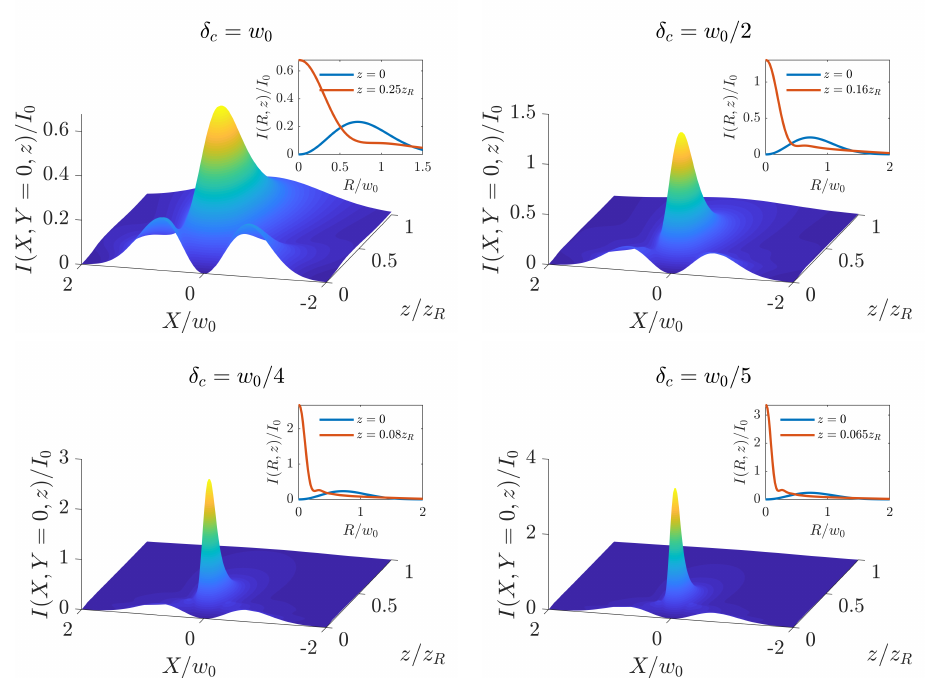
Figure 6. Evolution of the intensity profile with propagation distance for a beam with m = 1 and different values of the δ c / w 0 ratio [numerical evaluation of Equation (17) for free space propagation]. The insets show the intensity profile across the source plane and across the plane where the maximum intensity is